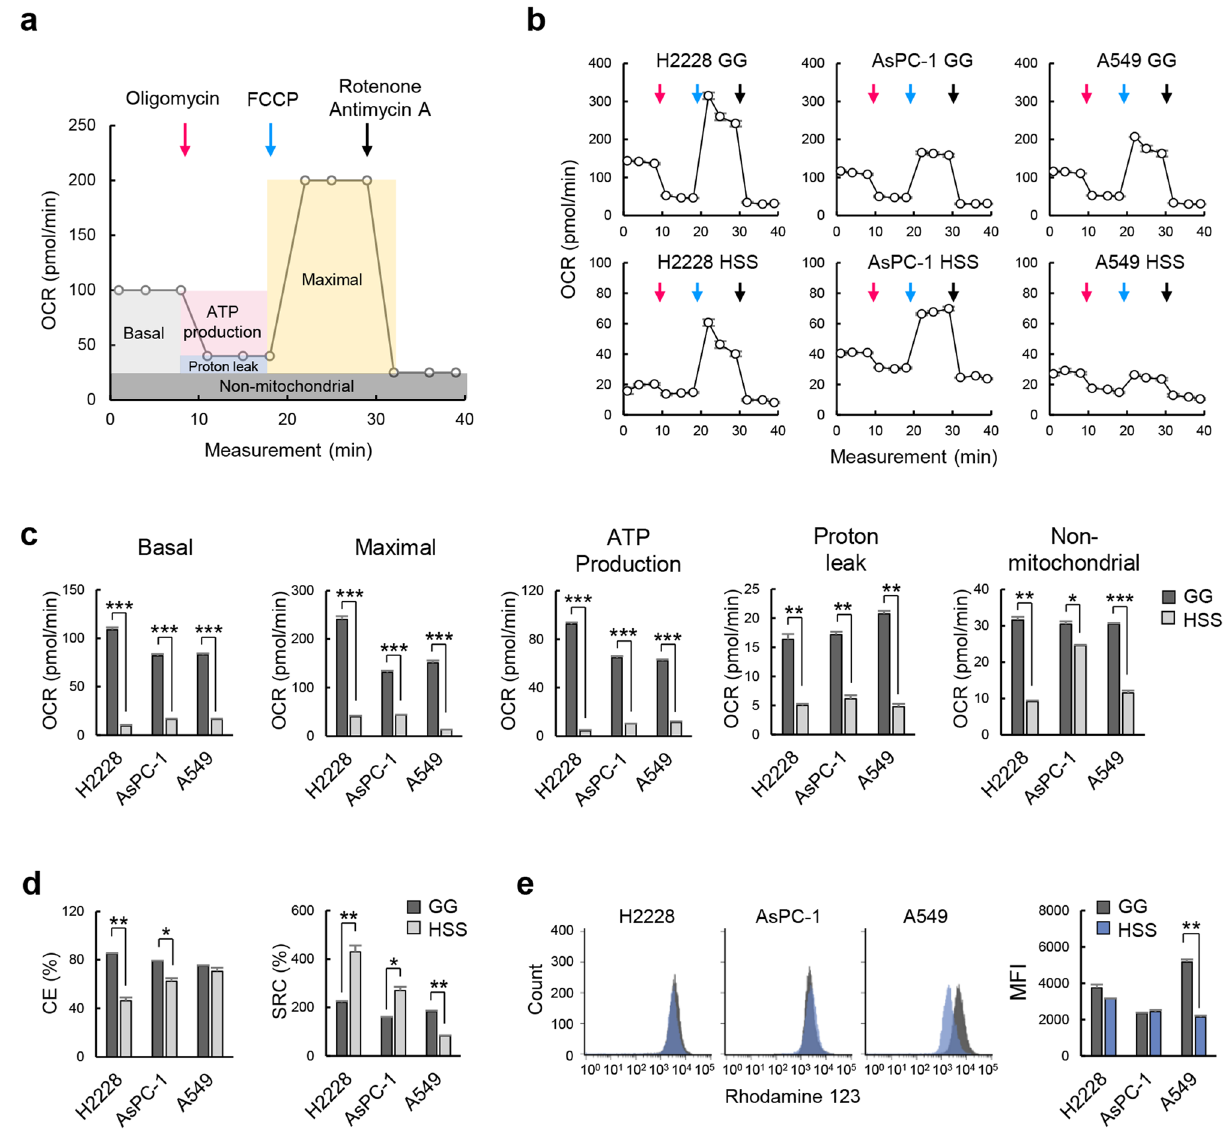
Figure 2. Quiescence-inducible cells generate small amounts of ATP by OXPHOS under HSS conditions. ( a ) Mitochondrial stress test profile of the key parameters of mitochondrial oxygen consumption rate (OCR). Basal, basal respiration; Maximal, maximal respiration; proton leak, proton leakage; non-mitochondrial, non-mitochondrial respiration. ( b ) OCR in H2228, A549, and AsPC-1 cells under GG and HSS conditions. Representative profiles are shown. Red, blue, and black arrows indicate the addition of oligomycin, FCCP, and rotenone and antimycin A, respectively. ( c ) The values of basal respiration (Basal), maximal respiration (Maximal), ATP production, proton leak, and non-mitochondrial respiration (Non-mitochondrial) from the profiles in ( b ). *** p < 0.001, ** p < 0.01, * p < 0.05; n = 3. ( d ) The coupling efficiency (CE) and spare respiration capacity (SRC). CE was calculated as a ratio of ATP production and basal respiration. SRC was calculated as a ratio of maximal and basal respiration. ** p < 0.01, * p < 0.05; n = 3. ( e ) Flow cytometric analysis of mitochondrial membrane potential of three cell lines under GG and HSS conditions. Representative histograms (left) and mean fluorescence intensity (MFI) values calculated from the histograms (right) are shown. ** p < 0.01; n =